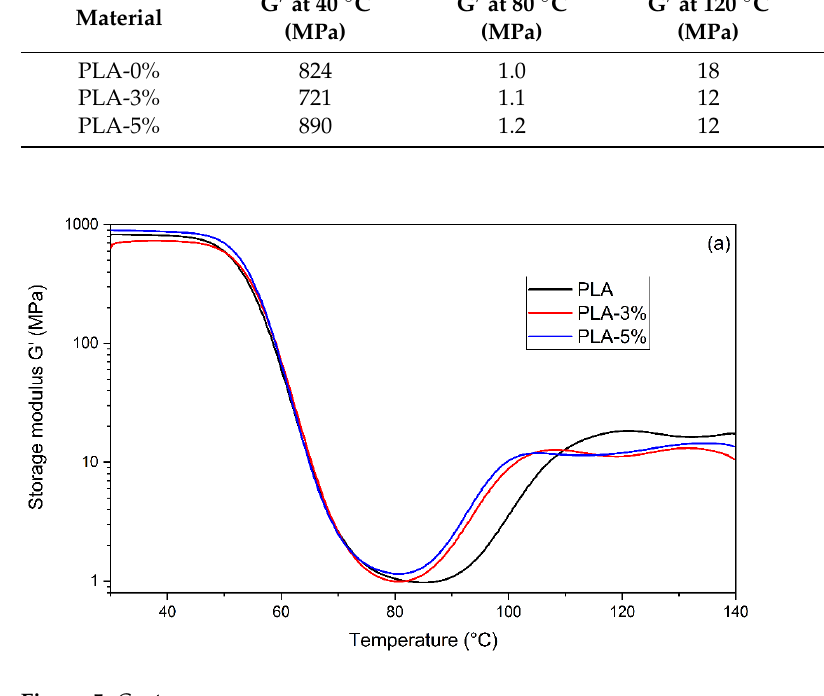
Figure 5. ( a ) Storage modulus and ( b ) tan(δ) variation as a function of temperature of PLA, PLA- 3%, and PLA-5% CaCO 3 fillers. 3.5. Microstructural Characterization Figure 6 presents the study samples ’ scanning electron microscopy (FESEM) results. This analysis assessed the final 3D-printed samples. In Figure 6a, on the left side, it is possible to note the fragile fracture section of the PLA. In Figure 6b and Figure 6c, the 3 wt.% and 5 wt.% CaCO 3 materials, respectively, are shown. In both cases, the presence of the natural filler (e.g., eggshells) is evident, since the surface of the materials is not as smooth as the PLA sample. In both cases, the samples ’ layers are not pasted, contrary to the shape detected in the PLA sample. The lack of adherence is explained by the presence of the CaCO 3 fillers, which affect the printing process of these formulations. Moreover, in Figure 6c, it is possible to observe the presence of porosity due to the filler content. The defects in the structure suggest a non-optimal adhesion between the CaCO 3 and PLA matrix [43]. These defects in the microstructure of the formulations led to the decrease in the mechanical properties (e.g., tensile strength and elongation at break) discussed above.